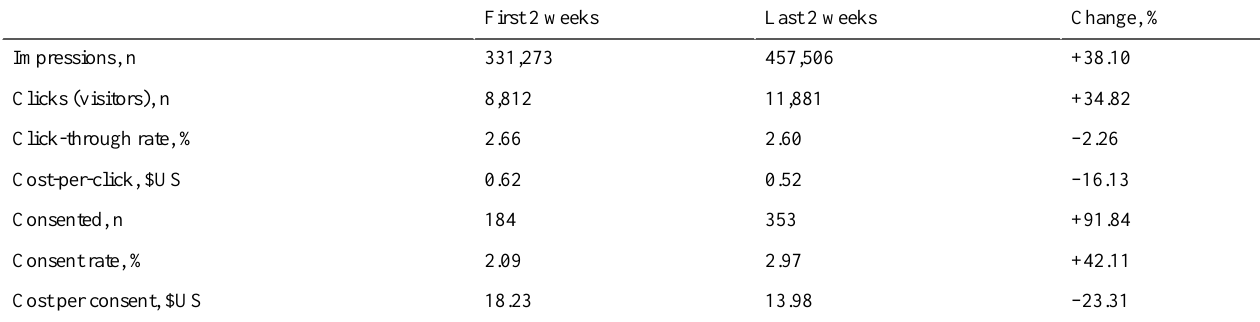
Table 6. Changes in ad campaign performance during the managed